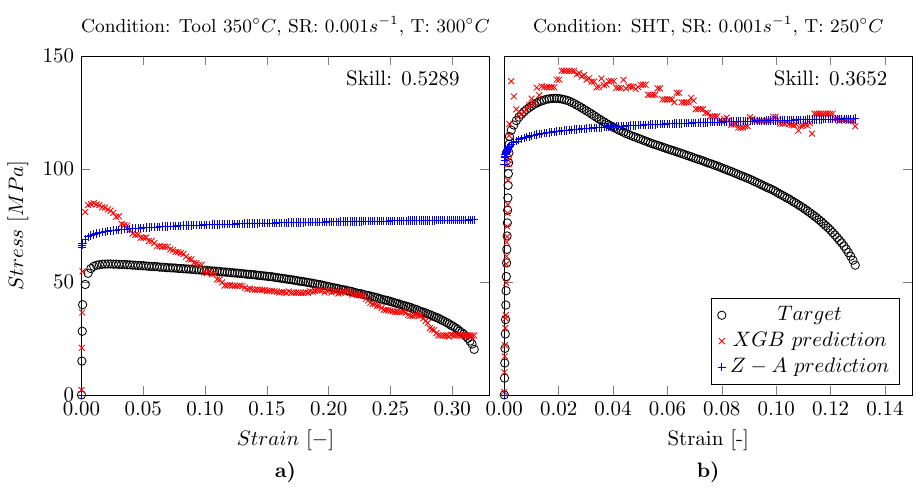
Figure 13. The two curves with the lowest test performance when applying the XGB model compared with model predictions of the Z–A model. Subfigure ( a ) shows the Tool 350 ◦ C condition at a strain rate of 0.001 s − 1 at 300 ◦ C whereas in ( b ) the Solution heat-treated (SHT) condition at a strain rate of 0.001 s − 1 at a temperature of 250 ◦ C can be